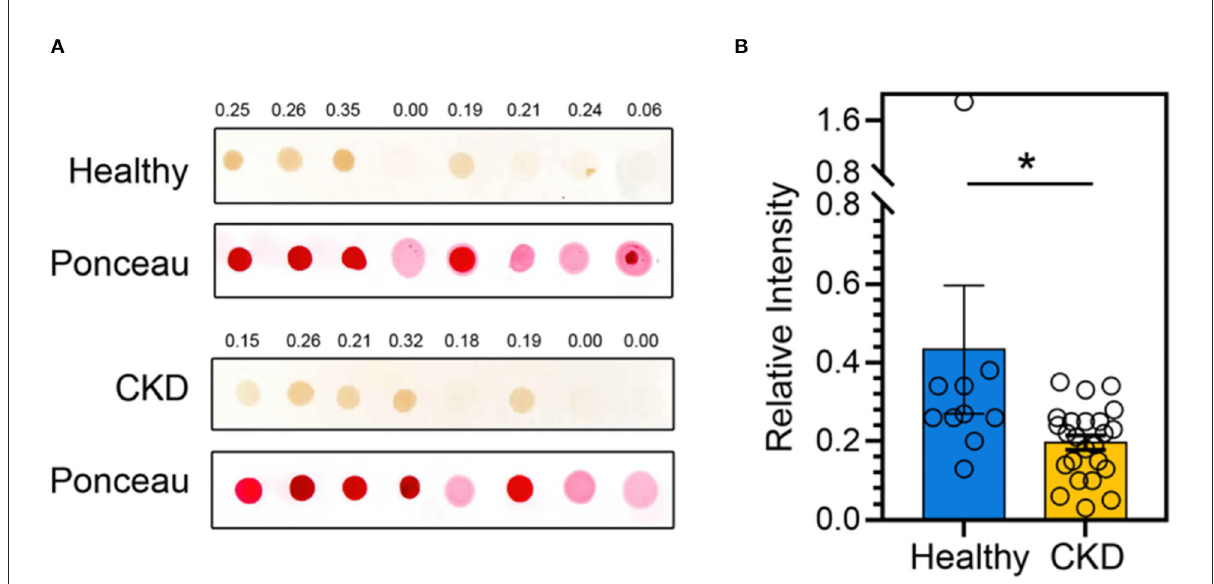
FIGURE4 (A) A representative dot blot of the Bcl-2 abundance of clinically normal age-matched (upper panel) and CKD cats (lower panel). Ponceau S staining is used in order to control the amount of protein loaded onto membranes. Relative Bcl-2 intensities are indicated at the top of each panel. (B) The bar graph depicts the mean and the standard error of the mean (SEM) of relative Bcl-2 dot intensity of clinically normal age-matched ( n = 11) and CKD cats ( n = 24). * P < 0.05. Statistical significance was determined using a generalized linear model